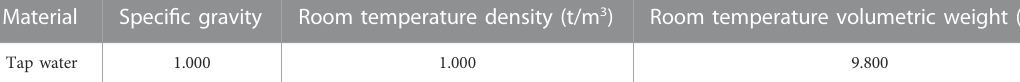
TABLE 3 Determination values of the water physical properties index.